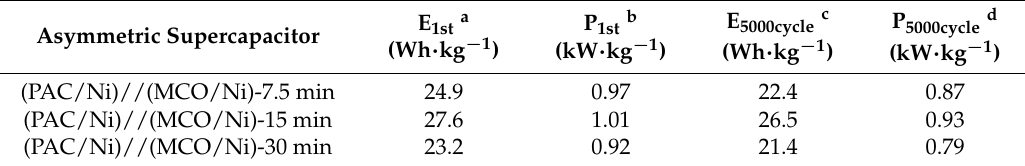
Table 2. Specific energy density and specific power density of (PAC/Ni)//(MCO/Ni ) asymmetric supercapacitors in 1st and 5000th